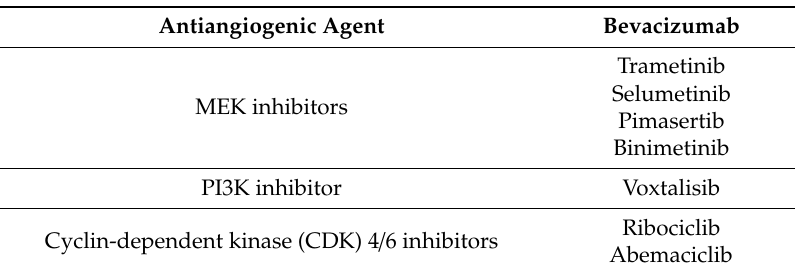
Table 2. Molecularly targeted agents tested in low-grade serous ovarian